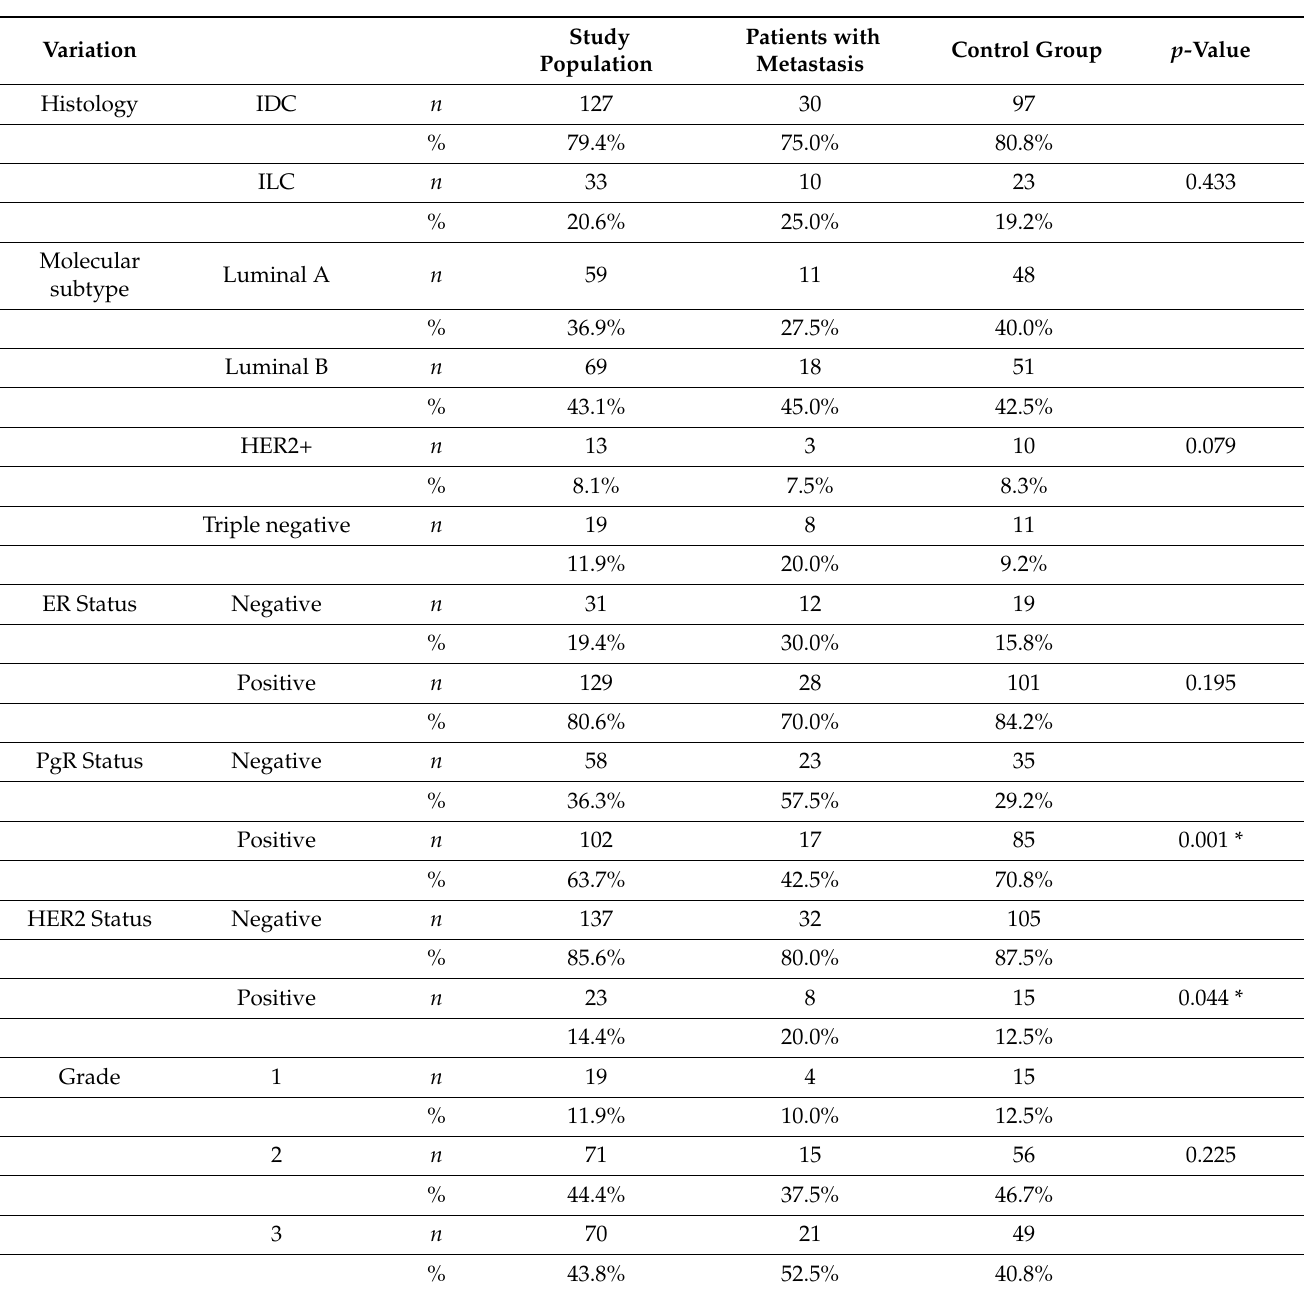
Table 2. Description of the extracted histologic characteristics. * indicates statistical significance ( p <